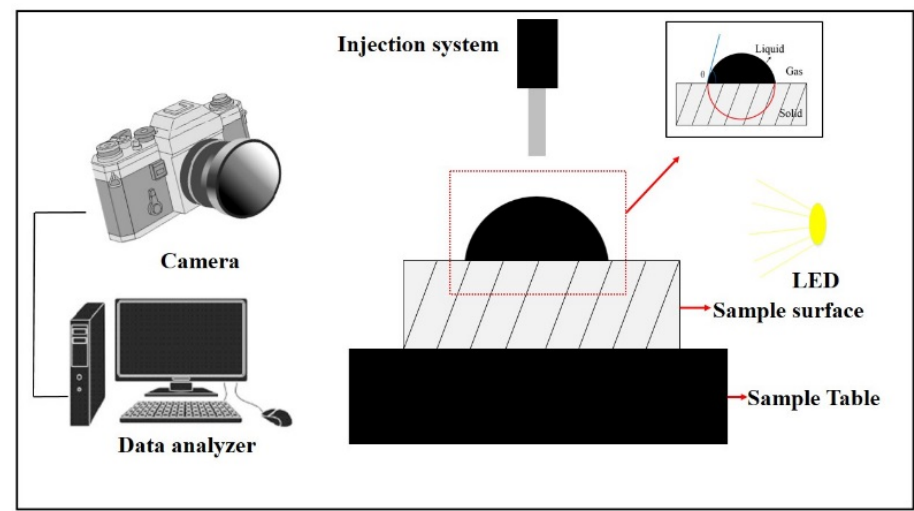
Figure 3. Schematic of the Contact Angle Measuring Device.